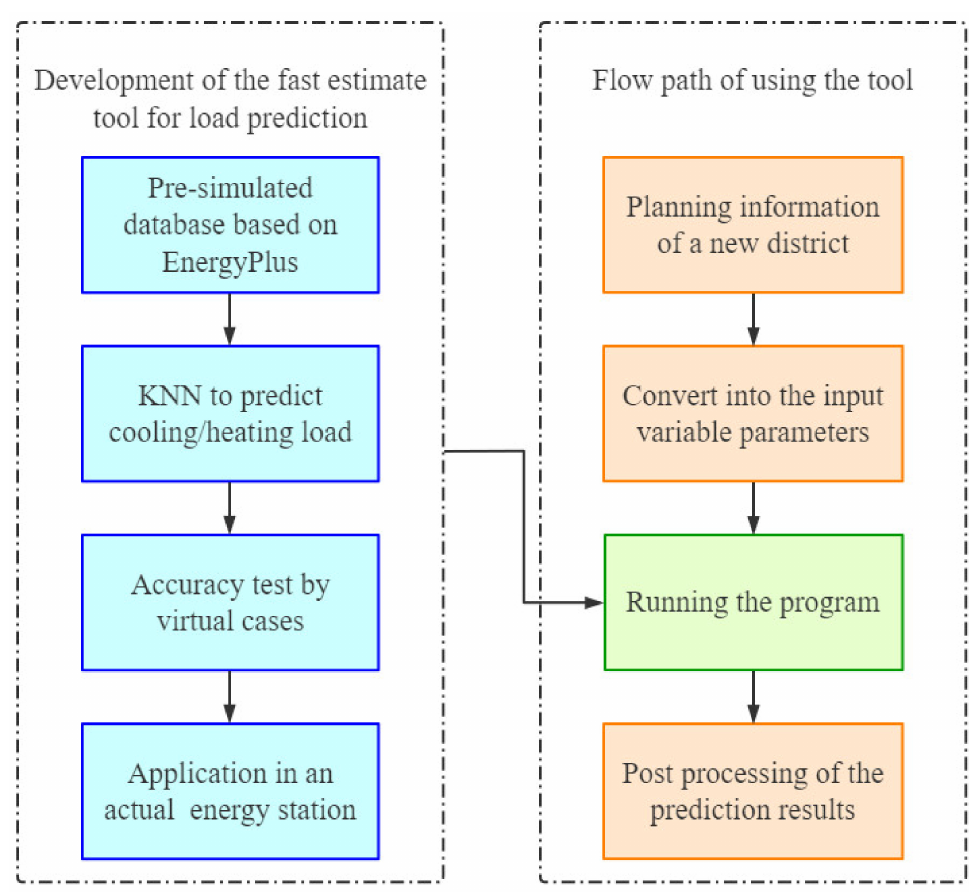
Figure 1. Flow chart of the